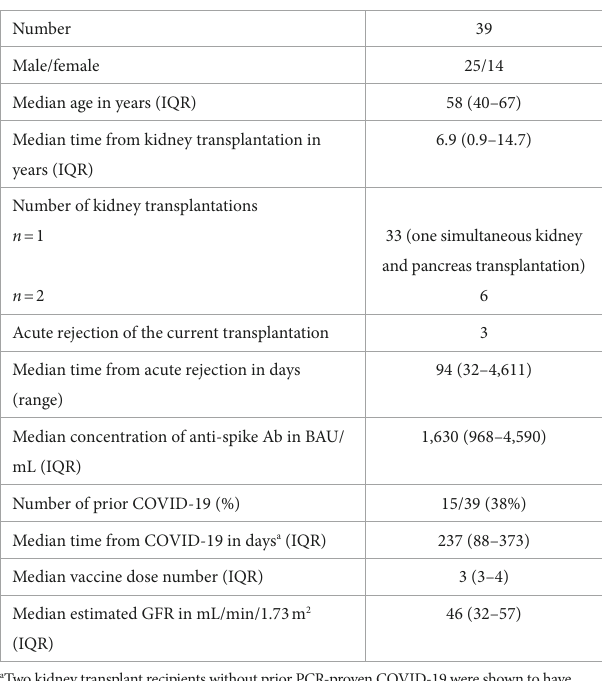
39 KTRs were tested using an automated Western blot assay to detect undiagnosed COVID-19. All patients reacted against the spike viral protein. Two KTRs without prior PCR-proven COVID-19 were shown TABLE 2 Characteristics of the 39 kidney transplant recipients at the time of serology.